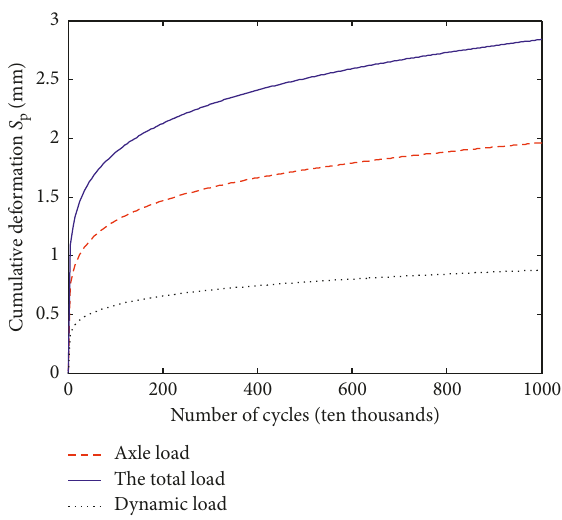
Figure 8: Development of cumulative deformation S number of cycles.